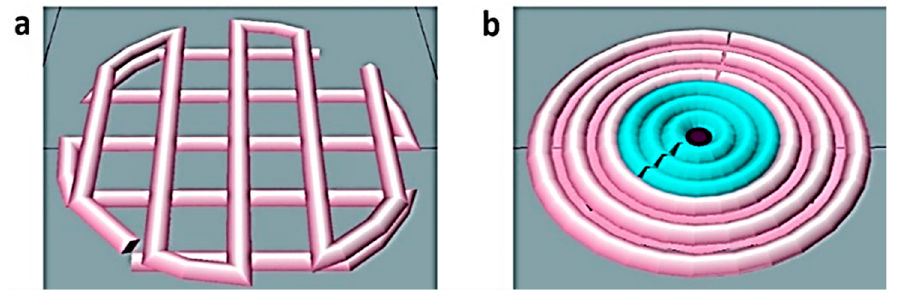
Figure 1. Schematic representation of the 3D printed constructs designed for the present study. For the initial experiments a simple grid-like structure was used ( a ), while the cancer model ( b ) consisted of a core of neuroblastoma cells (cyan) surrounded by healthy kidney cells (pink).